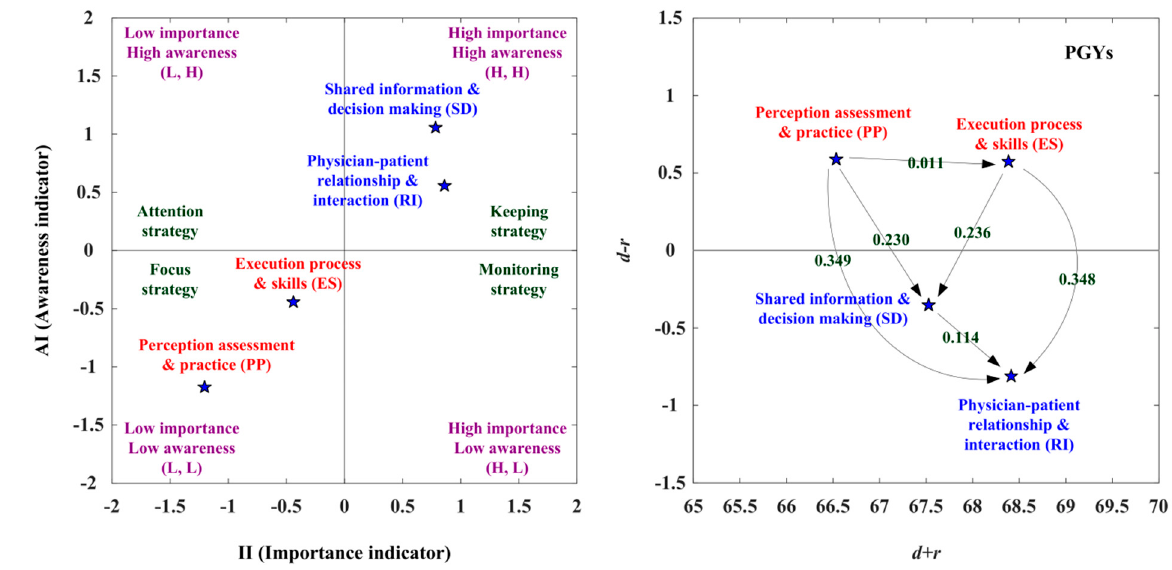
Figure 5. The SDM competency development map for PGYs. Table 10. The adoption strategy of SDM competency development for PGYs.